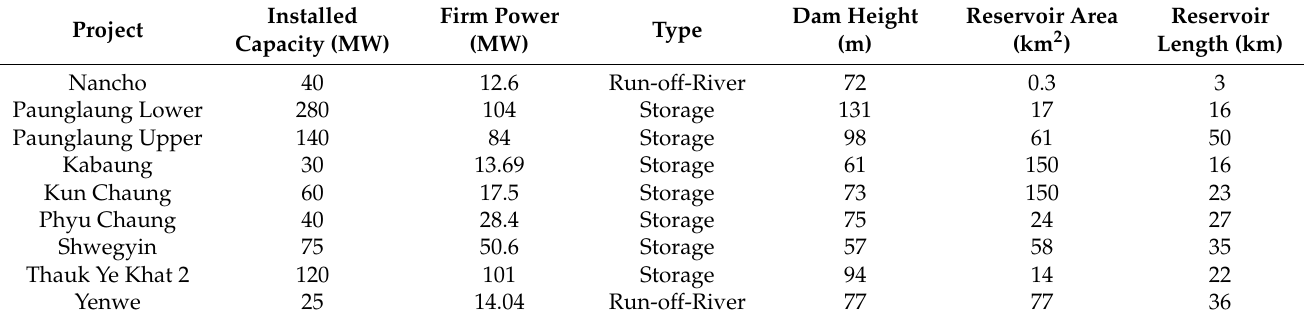
Table 4. Hydropower characteristics of the reservoirs selected in this